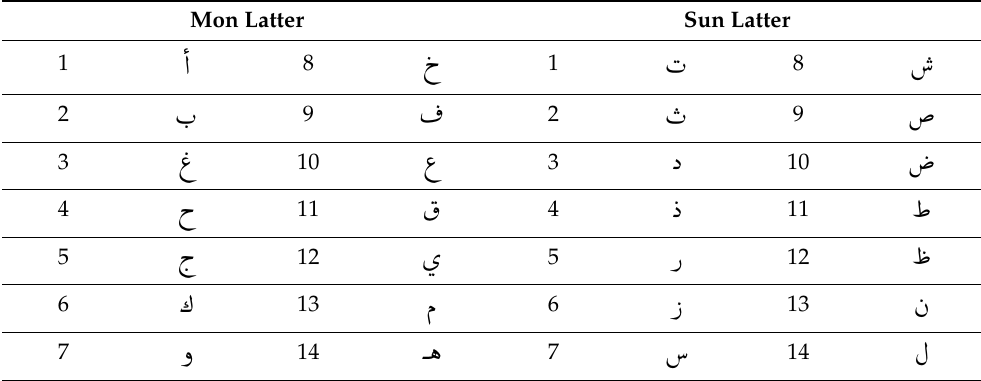
Table 8. Moon and sun letters (Adapted from [74]).